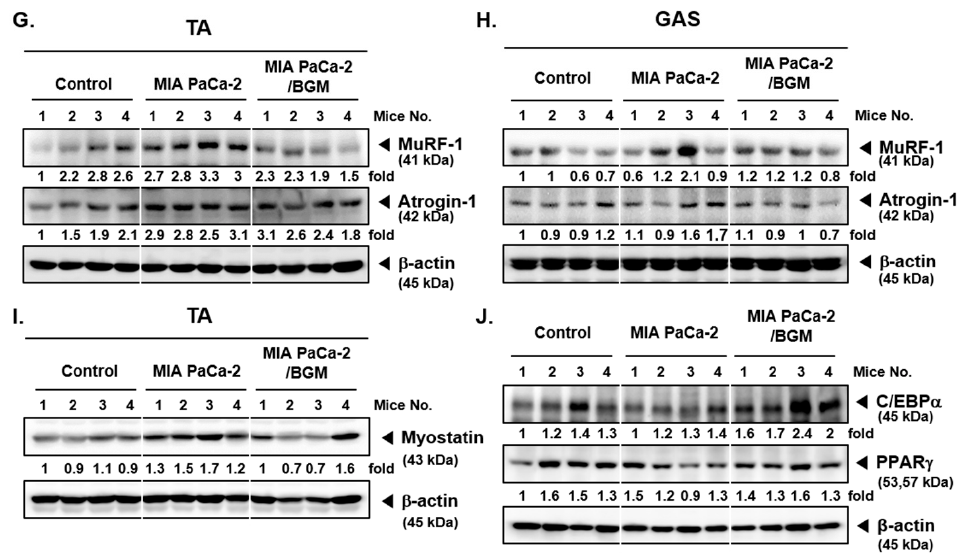
Figure 5. The suppression of muscle and adipocyte tissues atrophy in animal models upon BGM exposure. ( A ) MIA PaCa-2 cells (1 × 10 6 cells/mice) were injected subcutaneously into the right flank of the mice. After 1 week, the animals were randomized into 3 groups. Group I consisted of control mice, group II mice were injected MIA PaCa-2 cells, and group III mice were exposed to BGM (1 mg/kg) after MIA PaCa-2 cells injection. The mice were treated 3 times a week with BGM for 4 weeks and then sacrificed after 5 weeks. ( B , C ) Gastrocnemius (GAS) and tibialis anterior (TA) weight was measured on the last day of the experiment (mean ± SE). ( D , E ) Five-week change of body weight and food intake. ( F ) GAS, TA, and epididymal white adipose tissue (eWAT) were obtained from each control, MIA PaCa-2, and MIA PaCa-2/BGM groups were stained to compare cancer cachexia-induced atrophy. Scale bar = 50 µm. ( G , H ) The expression levels of E3 ubiquitin ligases Atrogin-1 and MuRF-1 were analyzed on TA and GAS by Western blot analysis. For this purpose, each sample was obtained from individual mice in an individual group. ( I ) Myostatin expression in TA was analyzed by Western blot analysis. ( J ) C/EBP α and PPAR γ expression levels in eWAT were observed by Western blot analysis. All the experiments were performed independently at least 3 times, and representative data are shown. Data represent means ± SD. * p < 0.05 vs. BGM, ** p < 0.01 vs. Control.